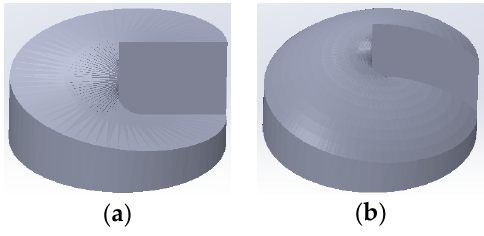
Figure 1. Structural diagram: ( a ) a SPP and ( b ) a convex spiral phaser.